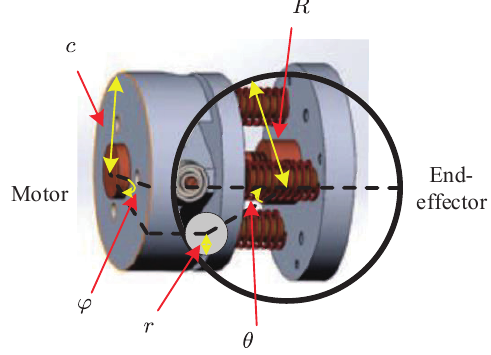
Figure 4. Mechanical structure of the